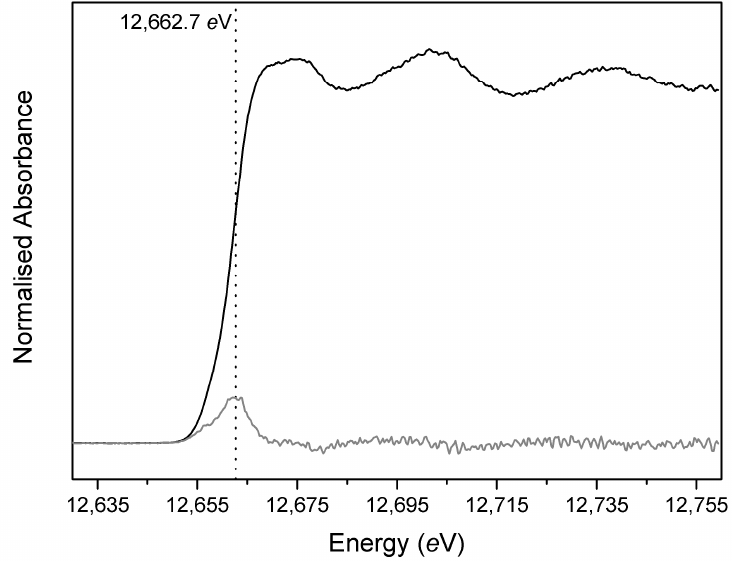
Figure 2. Normalized (black) and first derivative (grey) Tl L 3 -edge X-ray Absorption Near Edge Structure (XANES) spectrum.